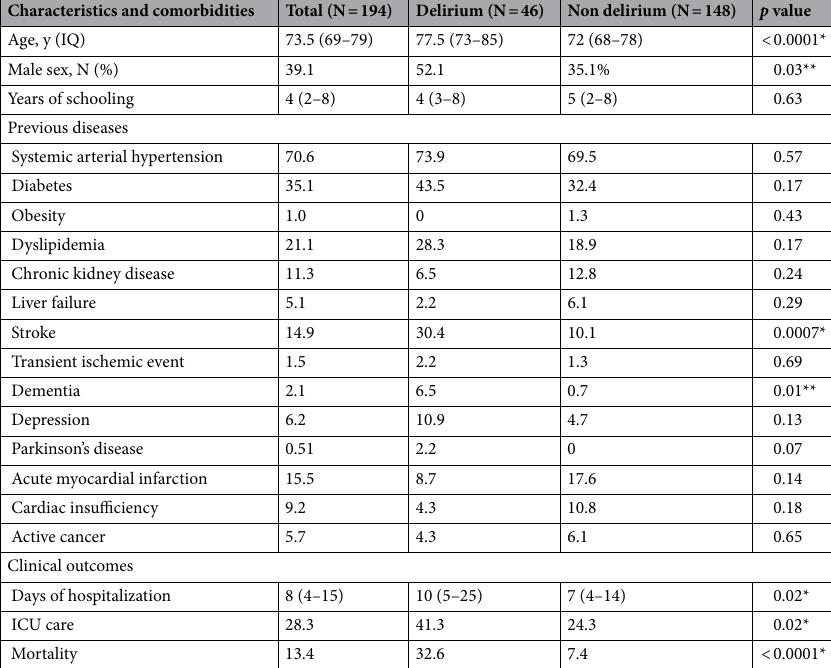
Table 1. Patient characteristics. Variables are expressed in percentage (%), except for age, years of schooling and days of hospitalization which are expressed in median (interquartile range). * p values were calculated using the non-parametric Mann–Whitney test for continuous quantitative variables. ** p values were calculated using Chi-squared test for categorical variables.